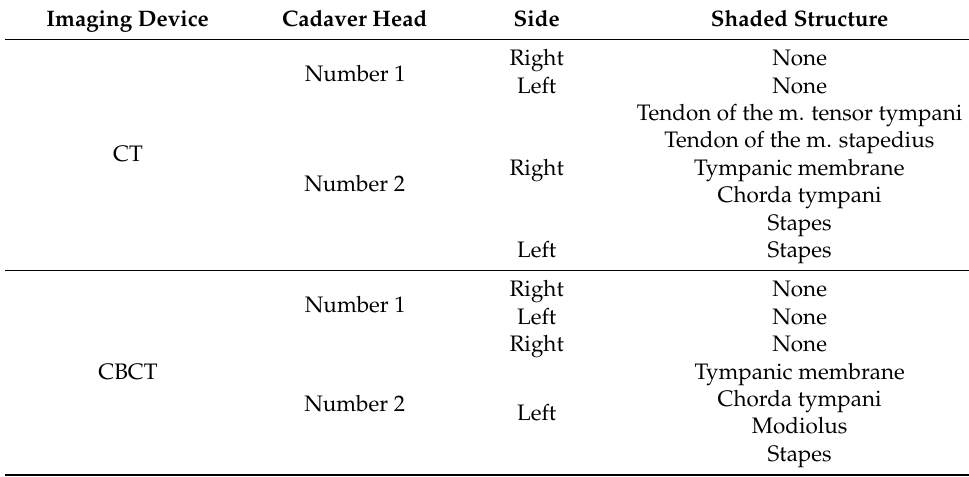
Table 3. Shading patterns depending on imaging